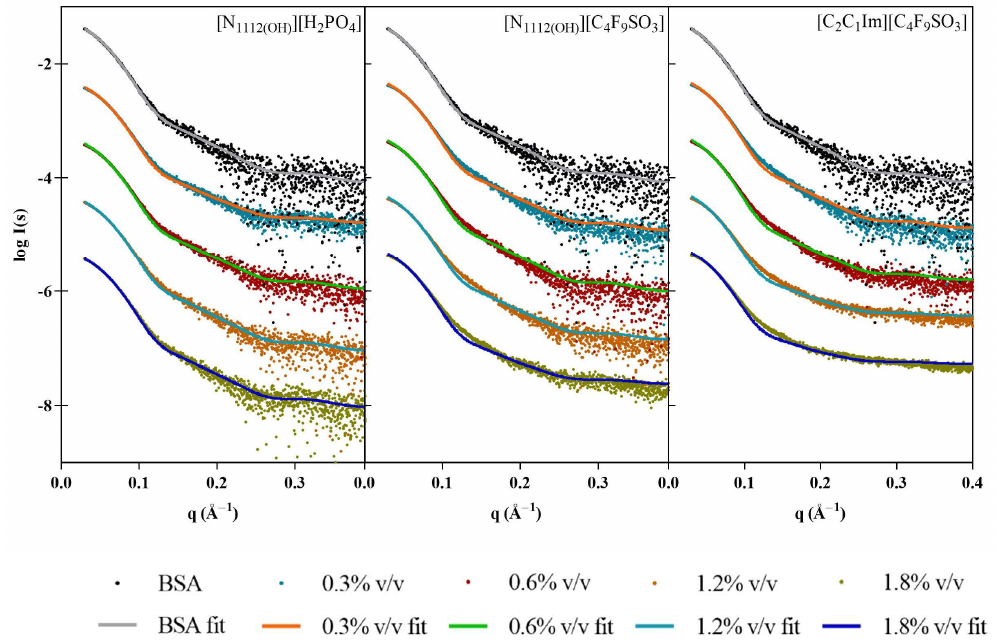
Figure 4. Scaled experimental scattering curves superimposed with fits obtained from OLIGOMER for BSA in the presence of [N 1112(OH) ][H 2 PO 4 ], [N 1112(OH) ][C 4 F 9 SO 3 ], and [C 2 C 1 Im][C 4 F 9 SO 3 ].